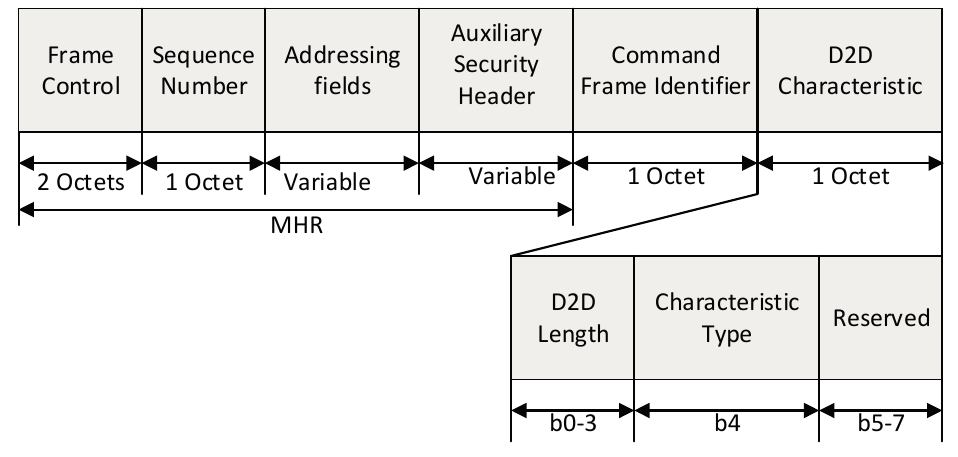
Figure 5. The format of a D2D request command